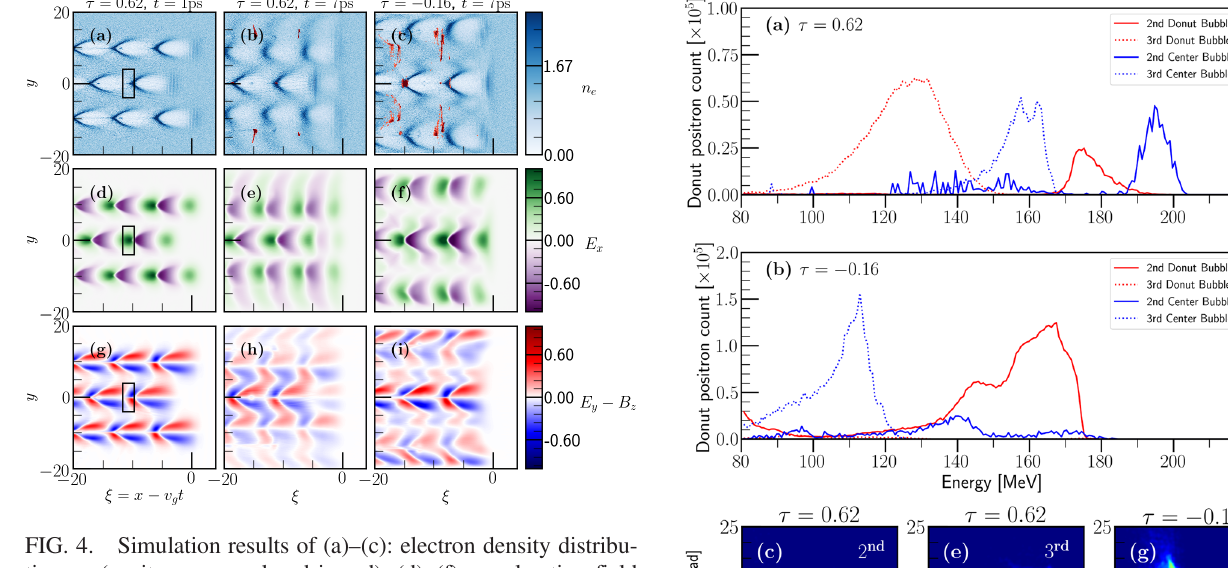
− B Þ in t ¼ 1 ps (near the y z